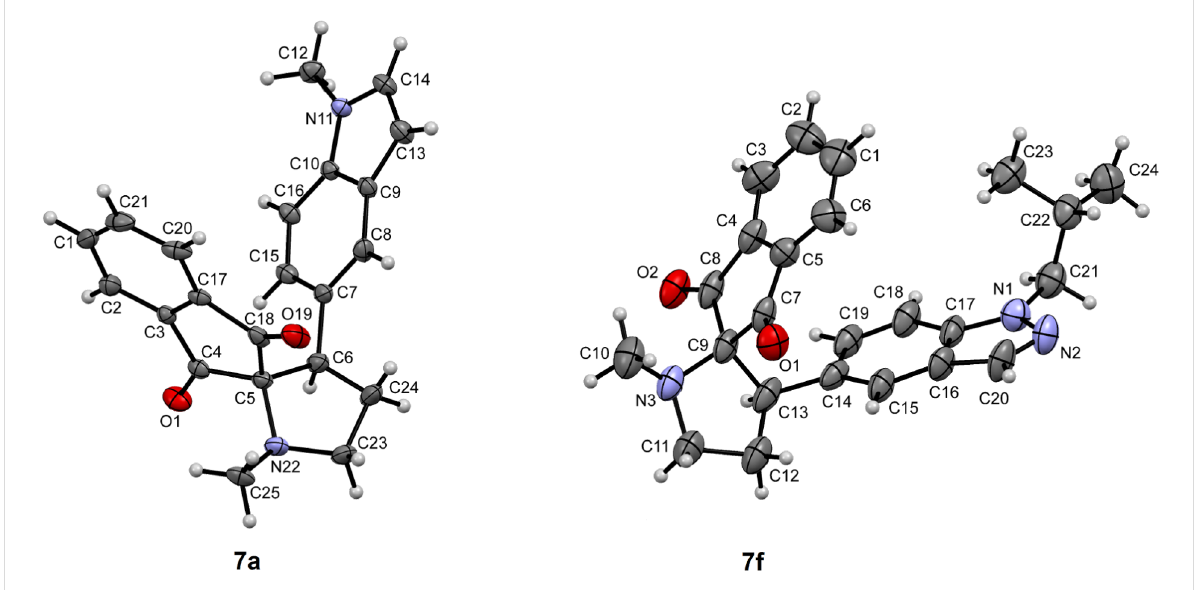
Figure 2: ORTEP representation of compounds 7a and 7f obtained by single crystal XRD study.